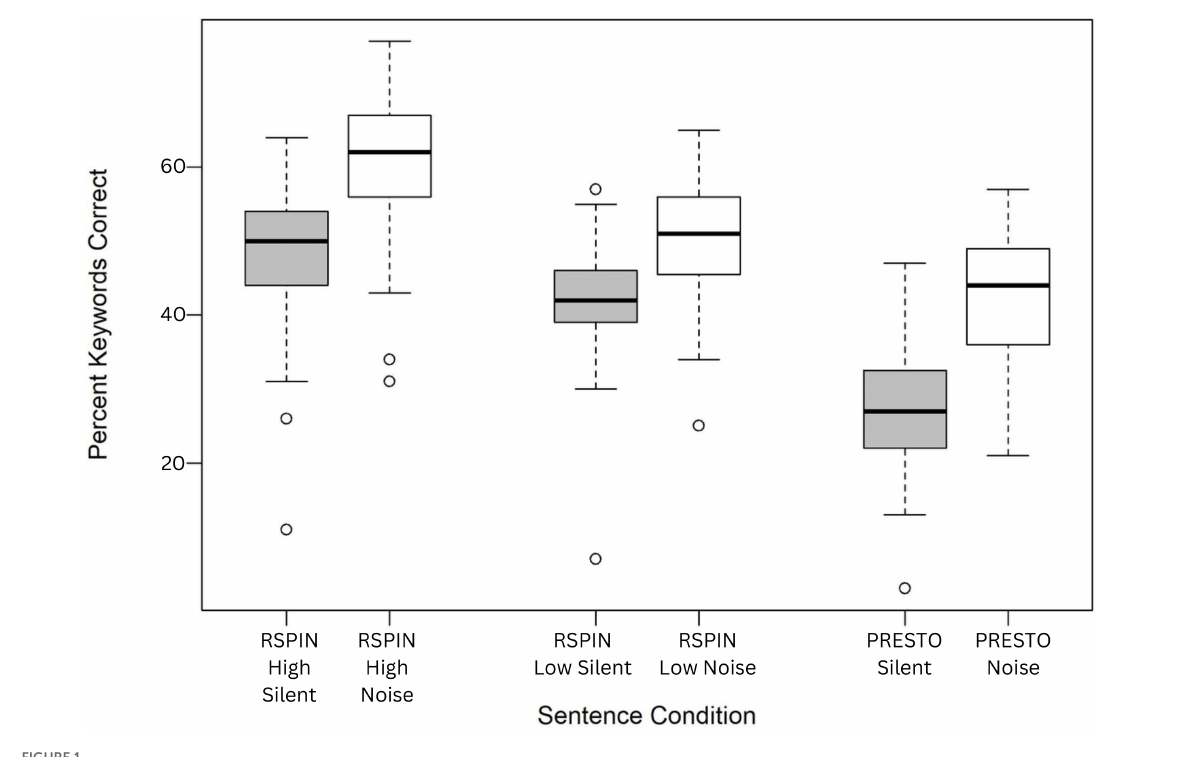
negative correlation with inhibitory control measured using the Flanker task ( r = –0.28, p = 0.02), which was the only significant correlation with the Flanker task across all measures, making it a weak predictor overall. Lexical processing speed recorded using the LexTALE word reaction time in milliseconds was positively and significantly correlated with inhibitory control measured